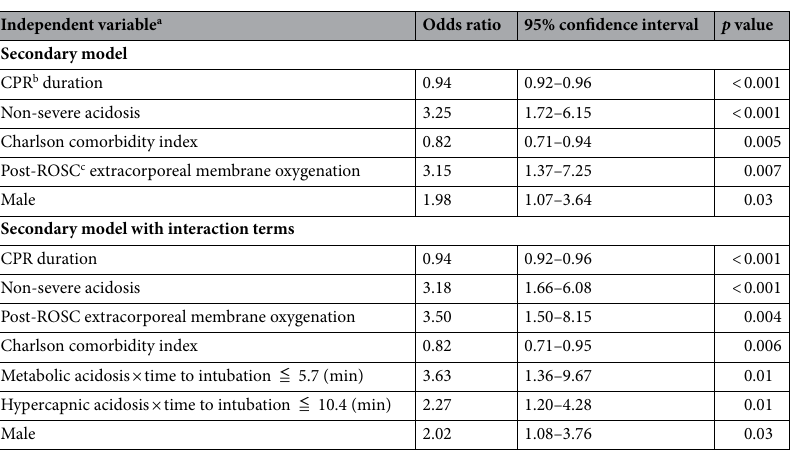
Table 4. Multiple logistic regression model with survival at hospital discharge as the dependent variable. Secondary model: goodness-of-fit assessment: n = 567, adjusted generalized R 2 = 0.29,estimated area under the receiver operating characteristic curve = 0.83, and Hosmer and Lemeshow goodness-of-fit Chi-Squared test p < 0.001; Secondary model with interaction terms: goodness-of-fit assessment: n = 567, adjusted generalized R 2 = 0.32, estimated area under the receiver operating characteristic curve = 0.84, and Hosmer and Lemeshow goodness-of-fit Chi-Squared test p < 0.001. a The display of independent variables is arranged in order of p value. b CPR, cardiopulmonary resuscitation. c ROSC, return of spontaneous